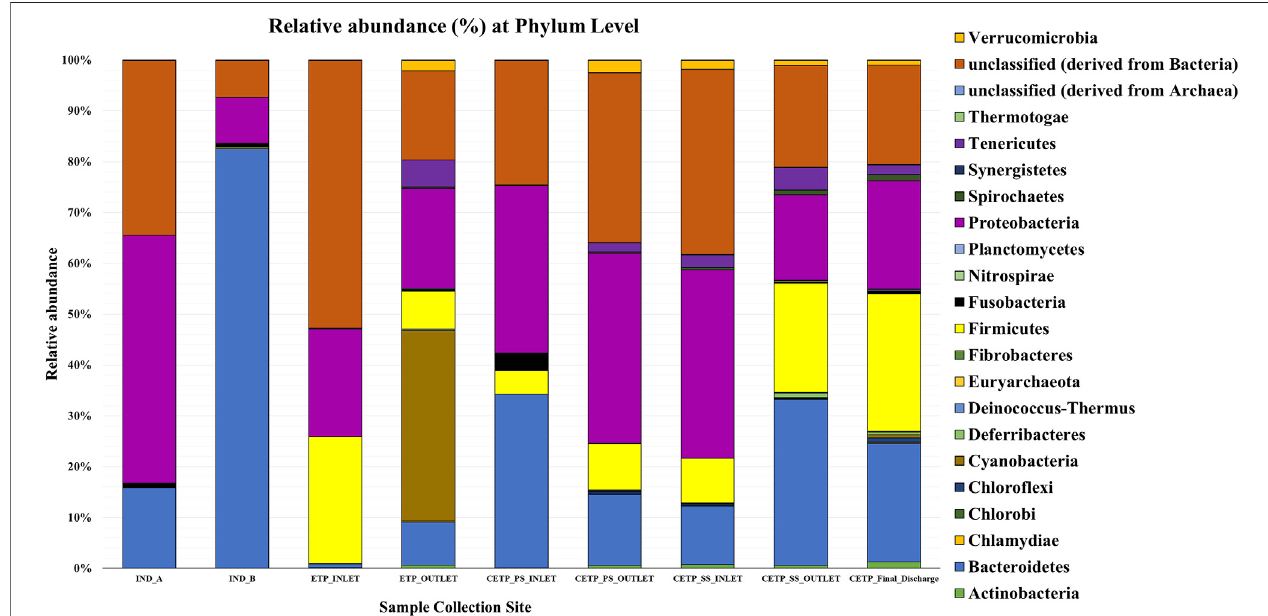
FIGURE 2 | Relative abundance (%) of the phylum-level taxonomic diversity in different metagenome samples collected from the textile industry wastewater site, common ef fl uent treatment plant (CETP), and ef fl uent treatment plant (ETP).